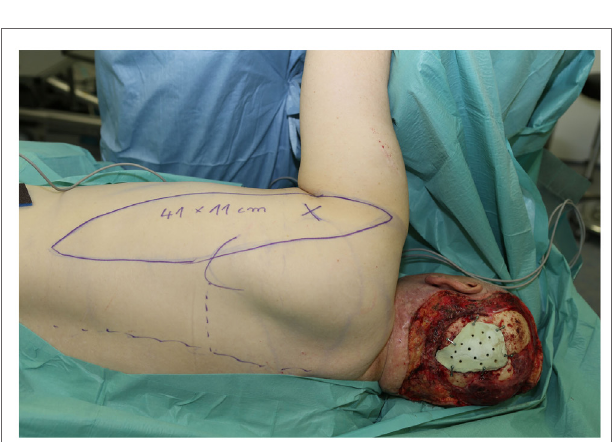
FiGURe 14 | The patient was initially positioned in a prone position . Note the extensive padding to reduce the incidence of pressure sores and the apparatus on the end of the bed that facilitates rotating the bed.